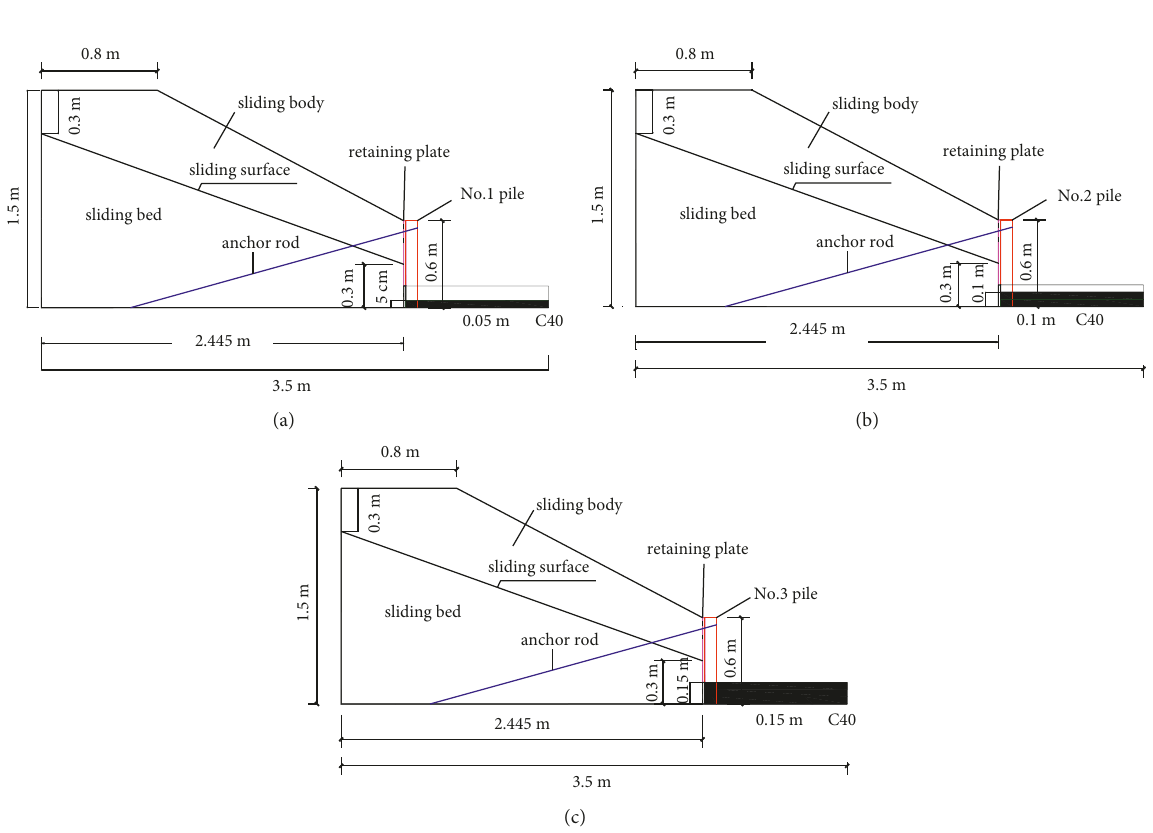
Figure 1: The schematic of the test models with different anchorage depths: (a) 0.05 m, (b) 0.1m and (c)